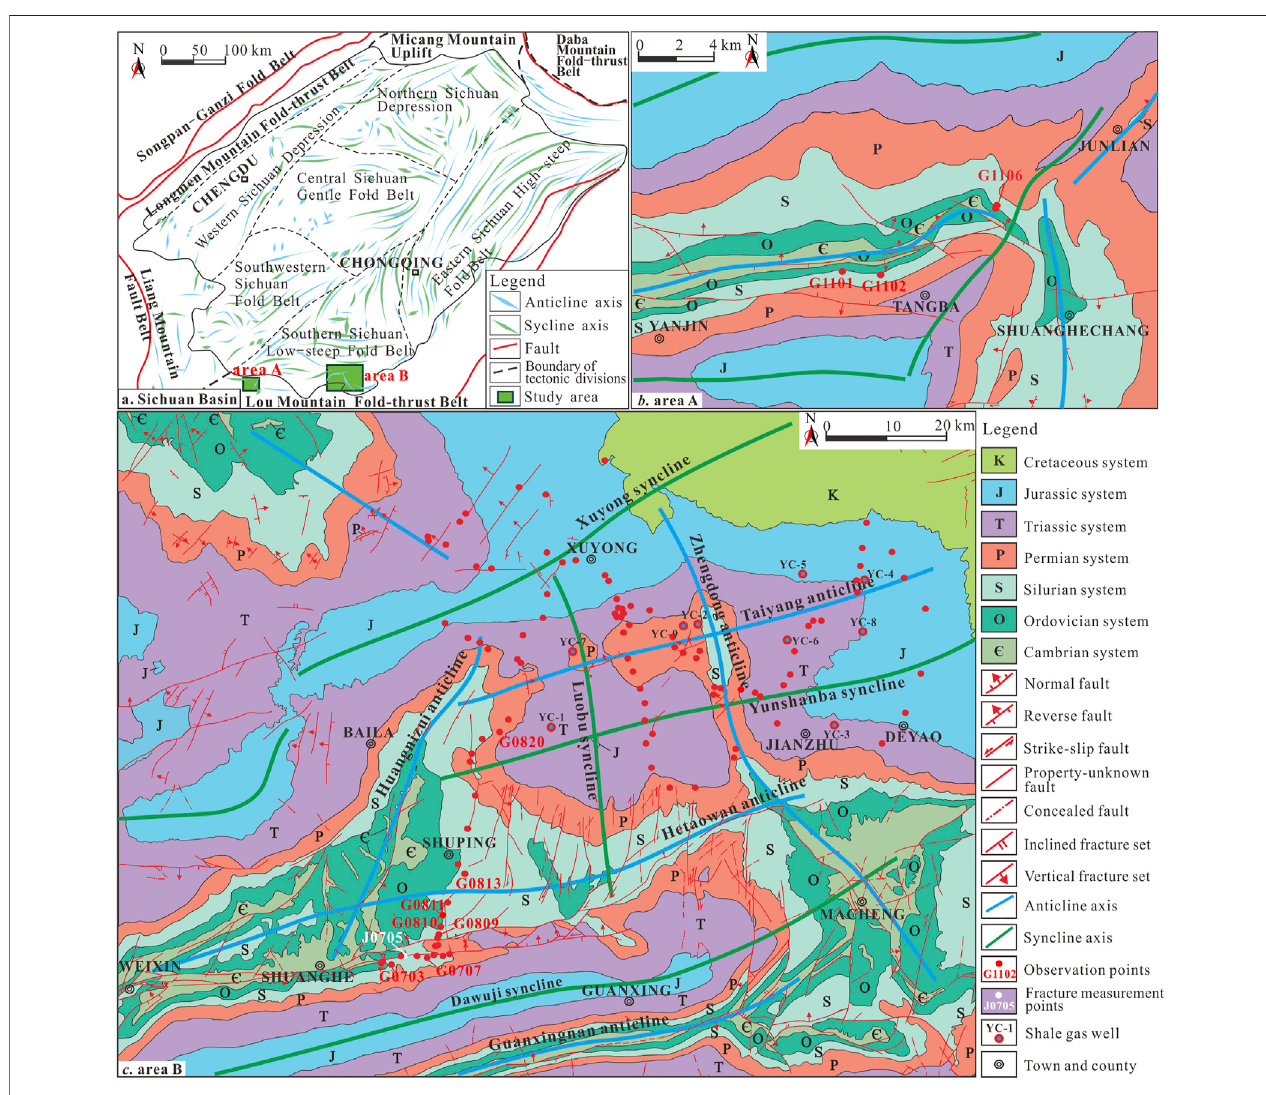
FIGURE 1 | Tectonic location (A) and structural outline map (B,C) of the study area.